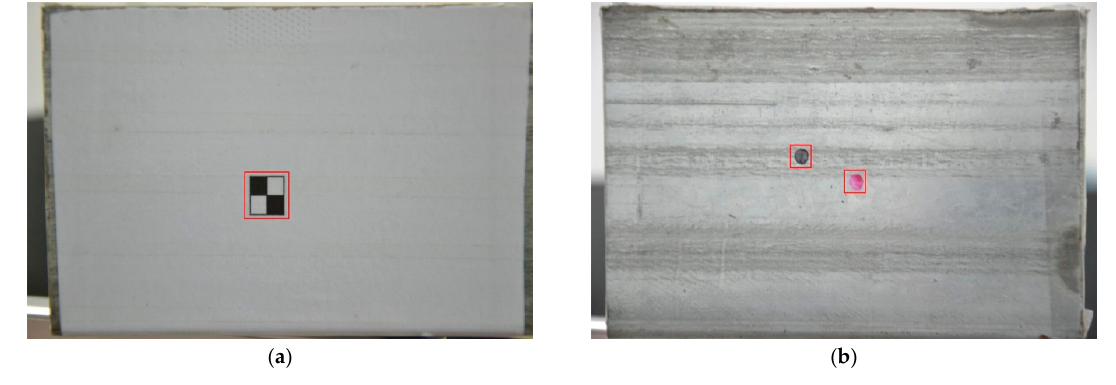
Figure 10. Target plate: ( a ) Artificial target; ( b ) Free targets.